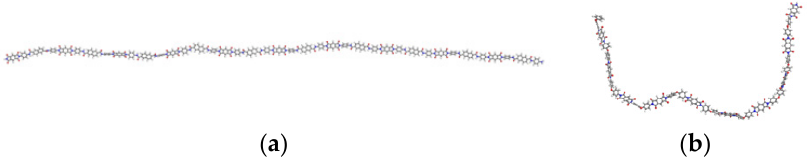
Figure 7. Single chain configurations (10 repeat units) of the ( a ) NAPPI and ( b ) Kapton [23].